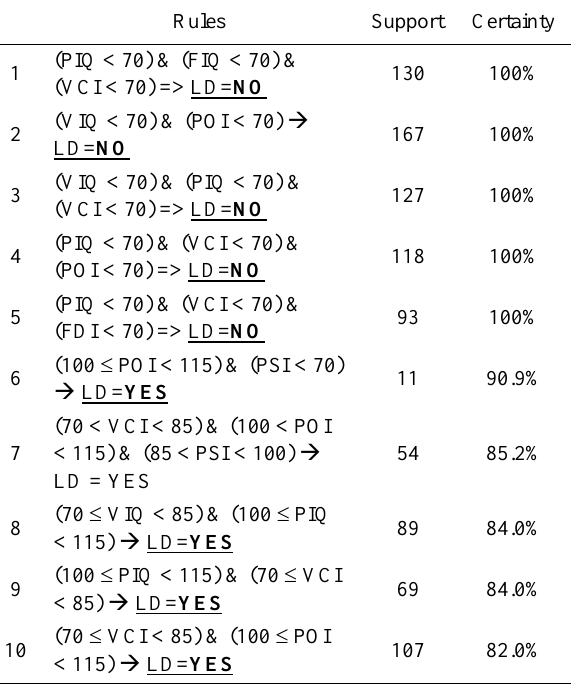
Table 14. Rules generated from data set A ∪ B with manual discretization and clustering prior to rules